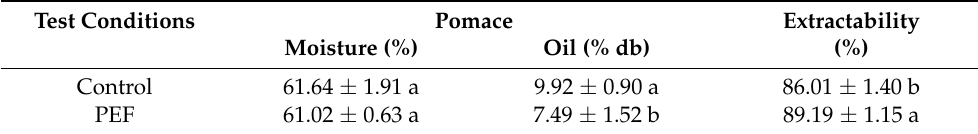
Table 1. Quantitative results and process parameters. Test Conditions Pomace Extractability Moisture (%) Oil (% db) (%) Control 61.64 ± 1.91